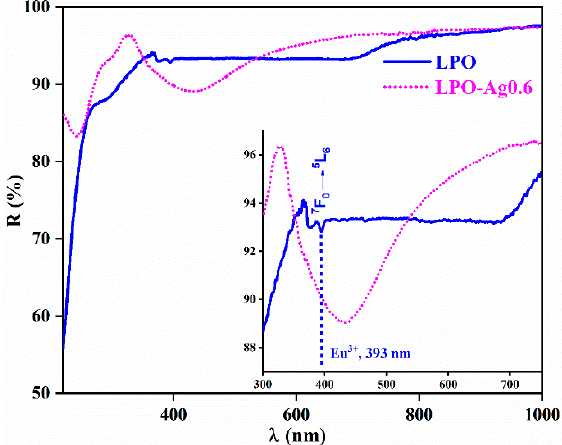
Figure 4. Diffuse reflectance spectra of the representative LPO (blue solid line) and LPO–Ag0.6 (pink-dotted line) sample. Inset: the dip in the reflection spectrum of the LPO–Ag0.6 sample centred at 430 nm is due to Ag plasmon absorption and it overlaps with the 7 F 0 → 5 L 6 absorption band of Eu 3+ .